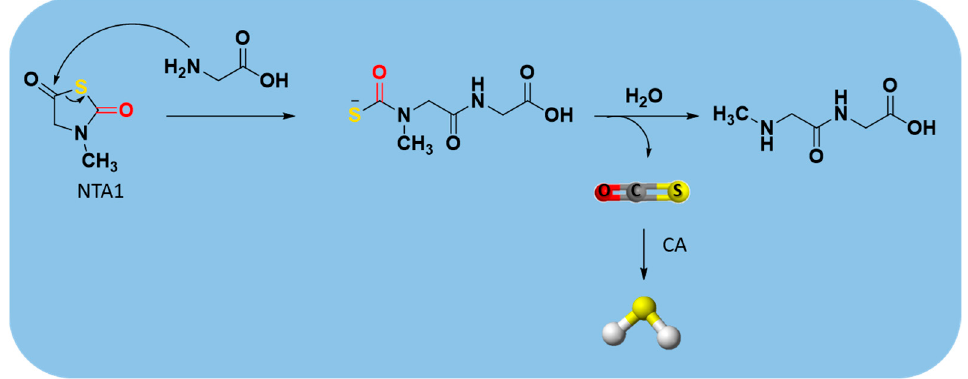
Figure 14. Mechanism of carbonyl sulfide (COS)/H 2 S release from NTA1.